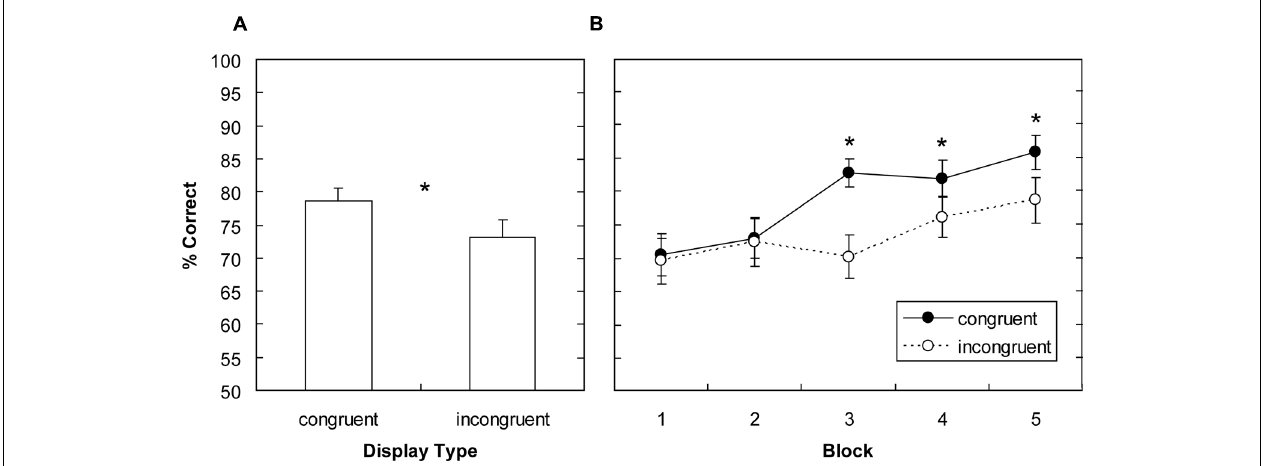
FIGURE 3 | Experiment 1: mean percentage of correct responses for global-congruent and -incongruent display layouts (A), and corresponding average response accuracies plotted as a function of